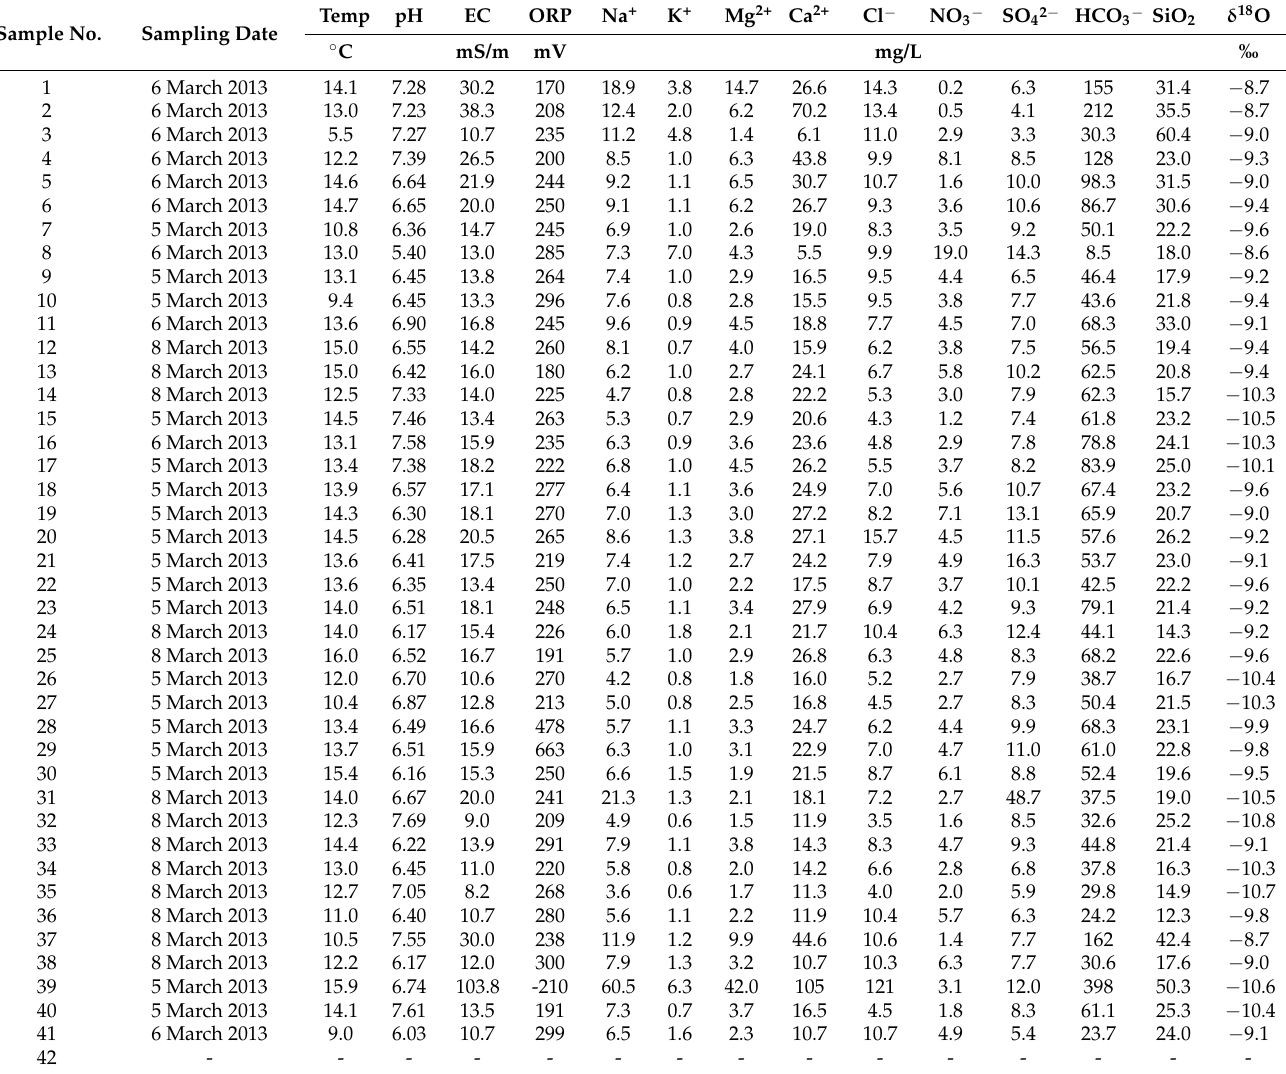
Table 12. Water temperature, pH, electric conductivity (EC), oxidation–reduction potential (ORP), chemical, and δ 18 O composition for groundwater samples in the Sho River alluvial fan on 5 March to 8 March 2013. Sample